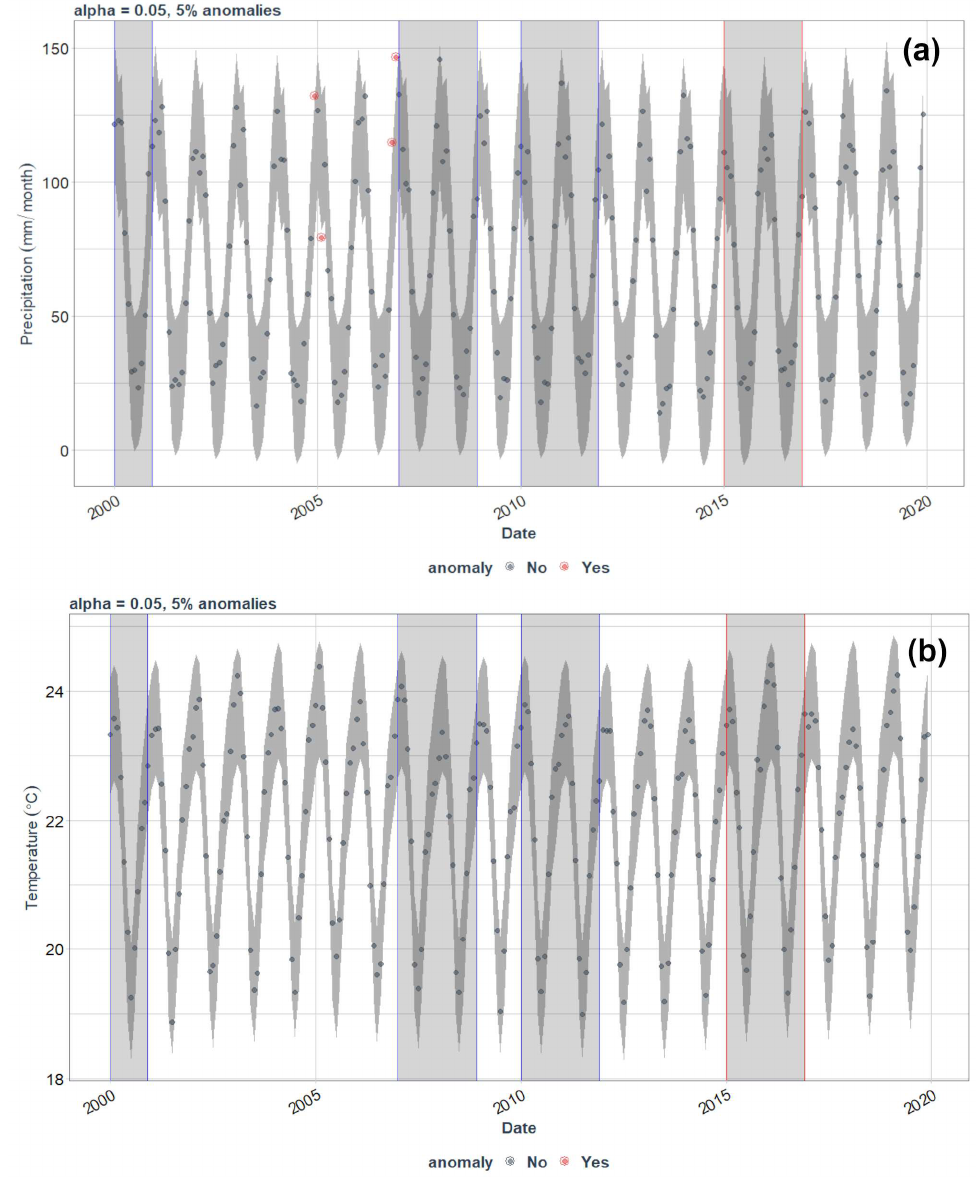
Figure 4. Interannual variability and anomalies of meteorological parameters detected by generalized extreme studentized deviate (GESD) from 2000 to 2020. ( a ) Precipitation (PCPN) and ( b ) temperature. The progressive u ( t ) and retrograde u (cid:48) ( t ) curves of precipitation (see Figure 2a) and temperature (see Figure 2b) do not indicate any significant trends. The overall trend for precipitation exhibits a slight decrease over the period, whereas the temperature does not show any significant trend. Therefore, the SQMK test for precipitation and temperature failed to reject the null hypothesis at the 95% confidence level. The summary of the SQMK results is shown in Table 2. The precipitation trends show a slight increase in the La Niña and El Niño periods. The temperature shows a slight decrease in the La Niña period and an increase in the El Niño